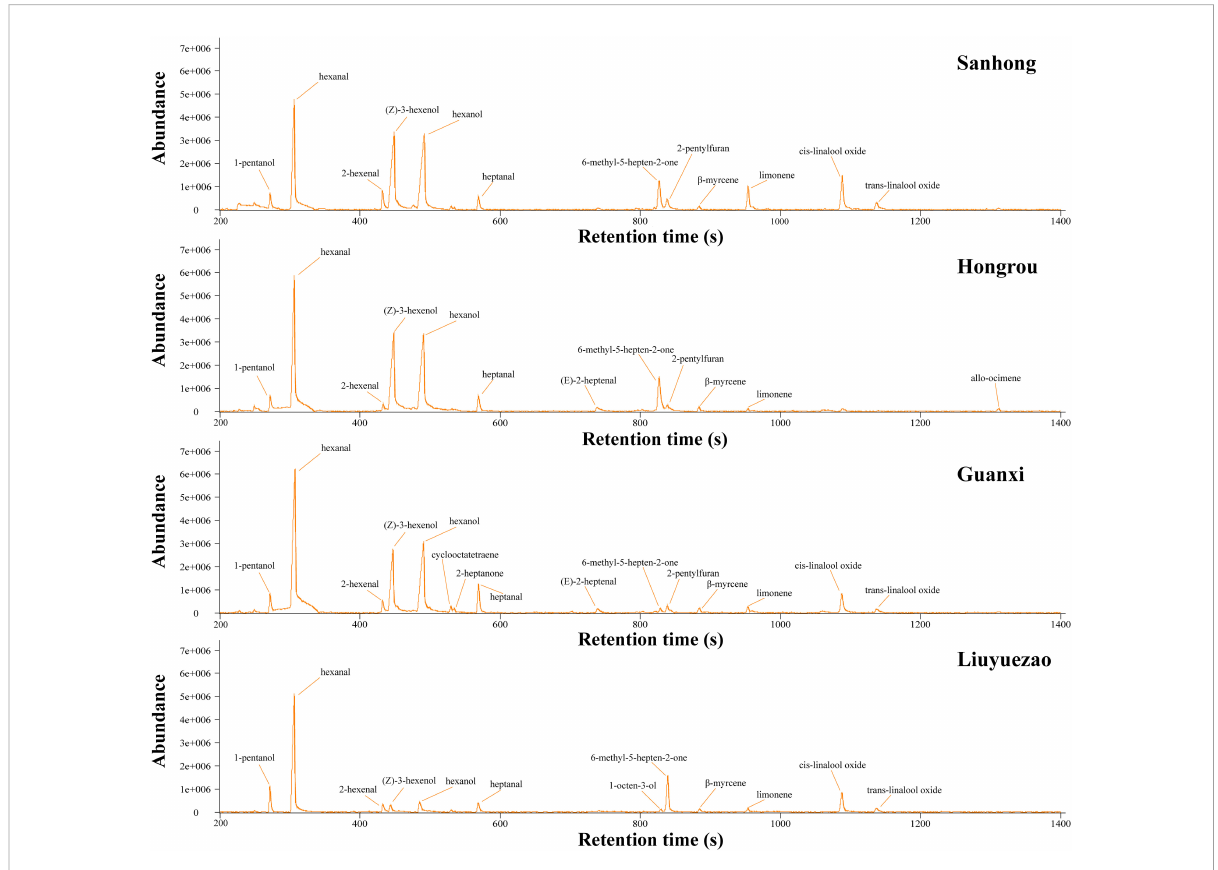
FIGURE 3 The TIC (total ion chromatogram) of pulp volatiles from the four pummelo